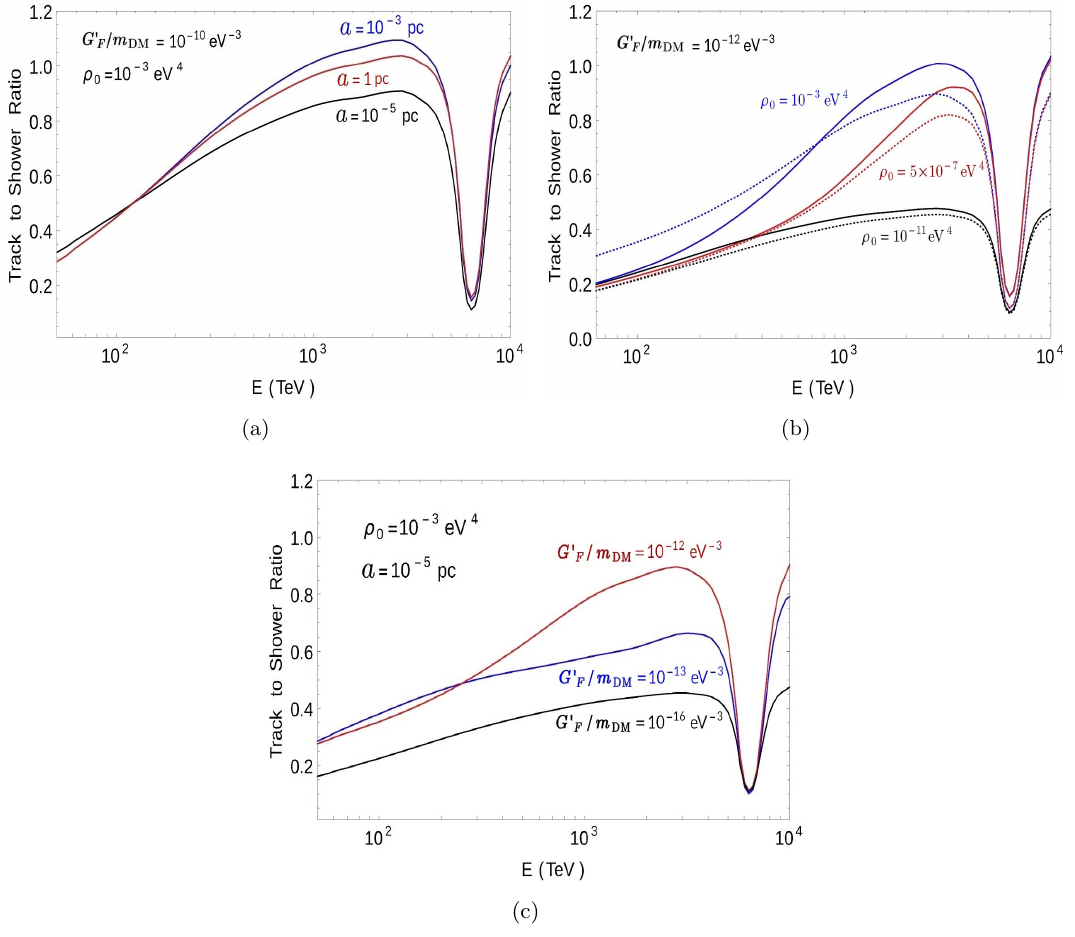
Figure 4 . Track to shower ratio vs. neutrino energy at z = 2 for varying values of (a) radius of the solitonic core a , (b) DM density at its centre ρ lines correspond to a = 1 pc (adiabatic case) and 10 − 5 pc (non-adiabatic case)